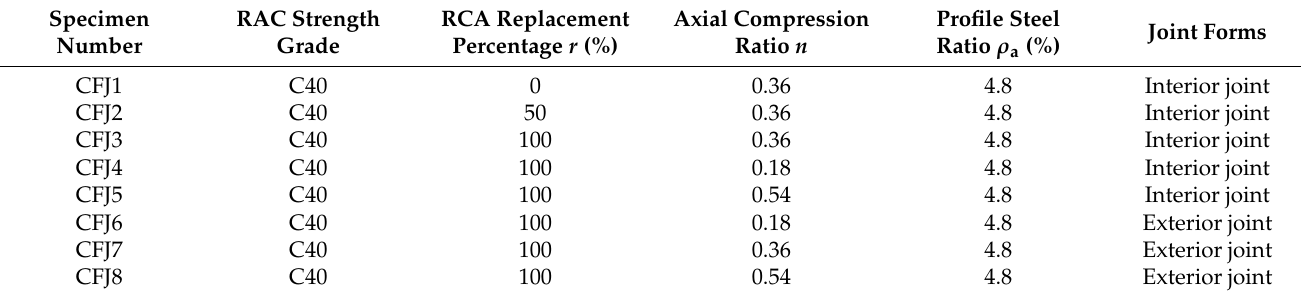
Table 3. Design parameters of joint specimens.